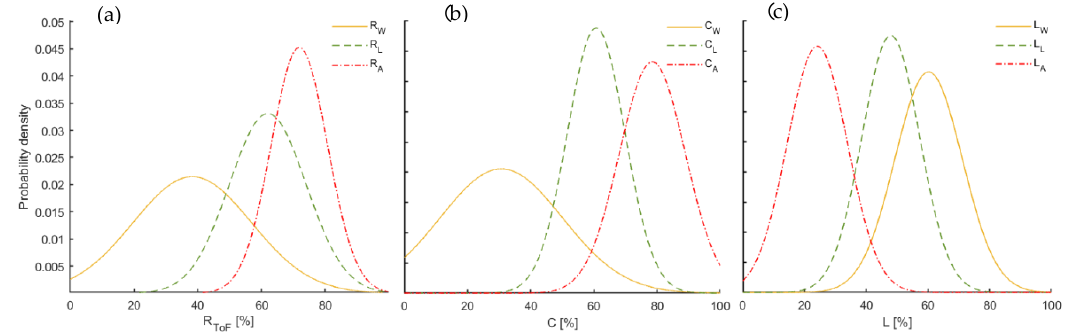
Figure 5. The probability density of ( a ) calibrated reflectance intensity (R ToF ) [%], ( b ) curvature (C) [%], and ( c ) linearity (L) [%] for wood, leaves, and apples.